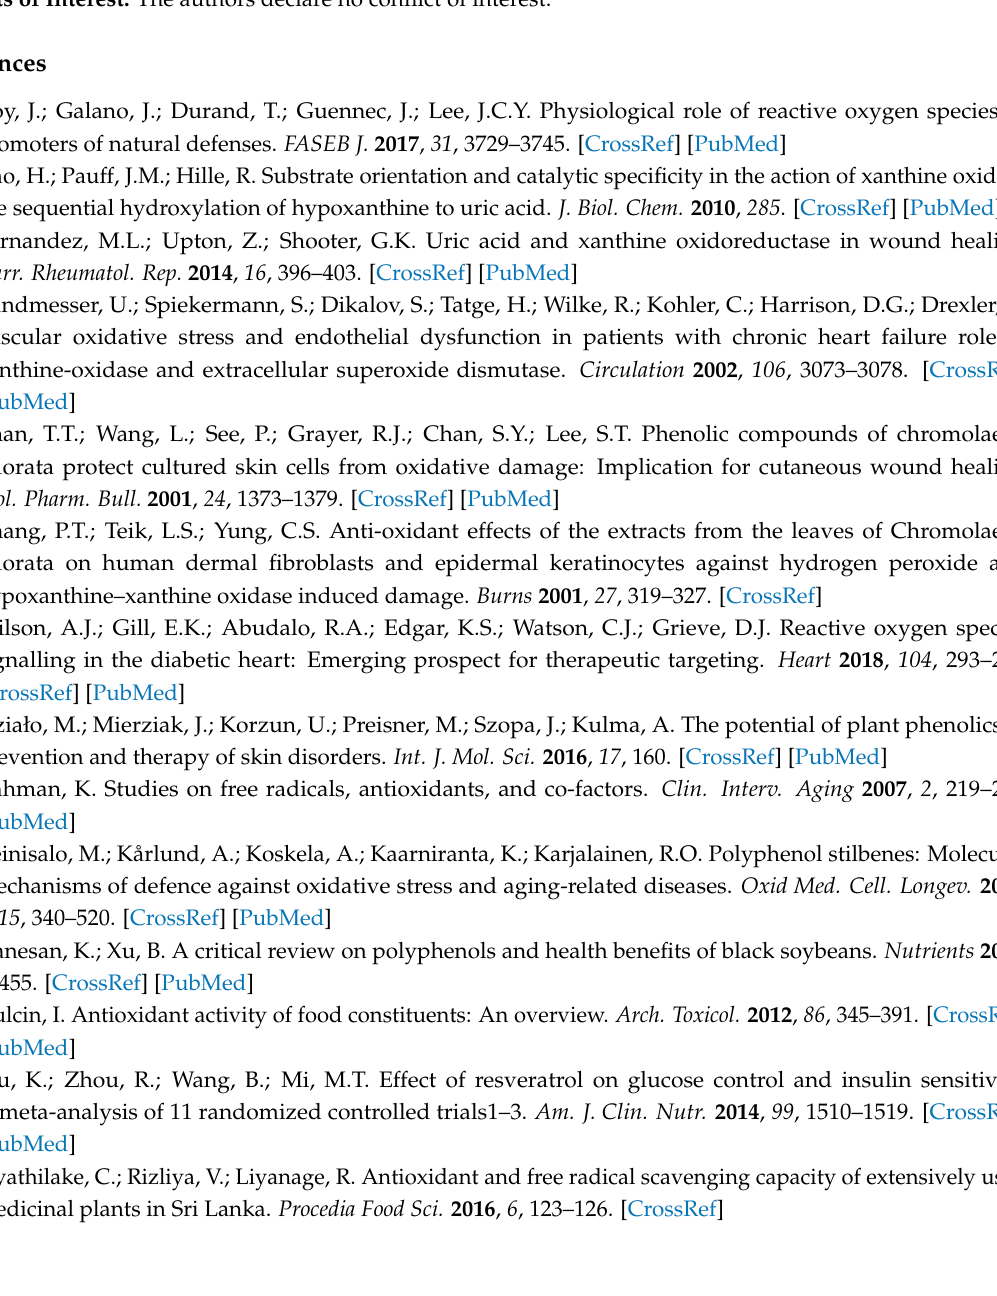
Figure S1: Potential electrostaic maps of the identified compounds in the Curatella amerina L . leaves; Figure S2: The transition status of frontier orbital (HOMO and LUMO) compounds 2 , 7 – 12